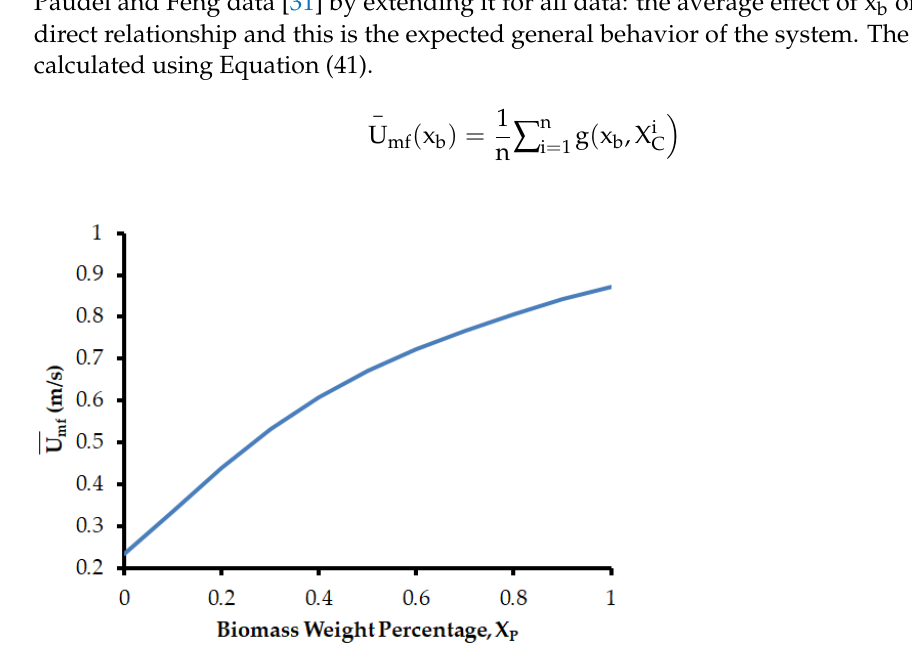
Figure 6. Simulations using Model 1. Average effect of biomass fraction calculated with the PDP.